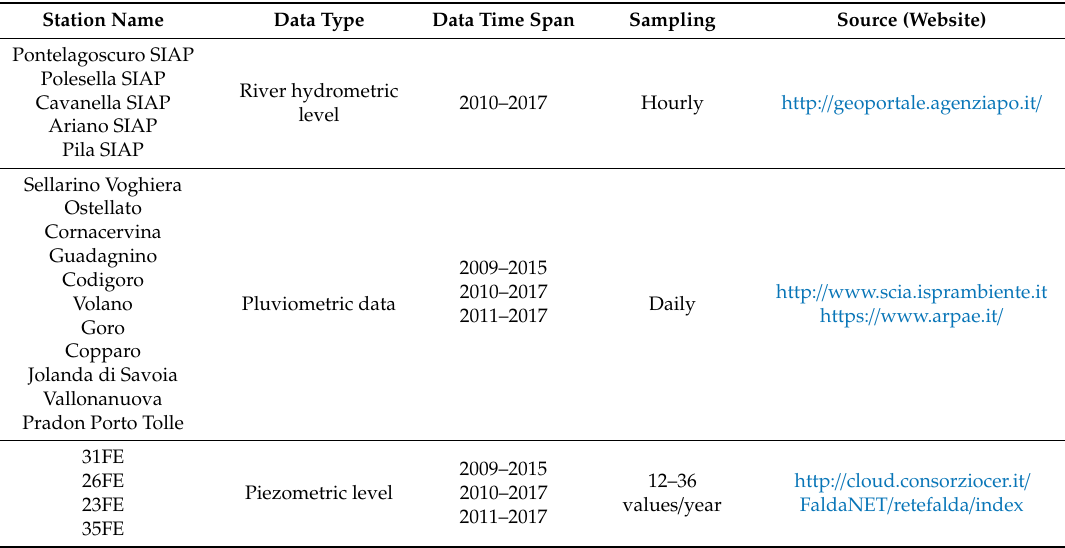
Table 1. List of the selected stations and web sources of the hydro-meteorological